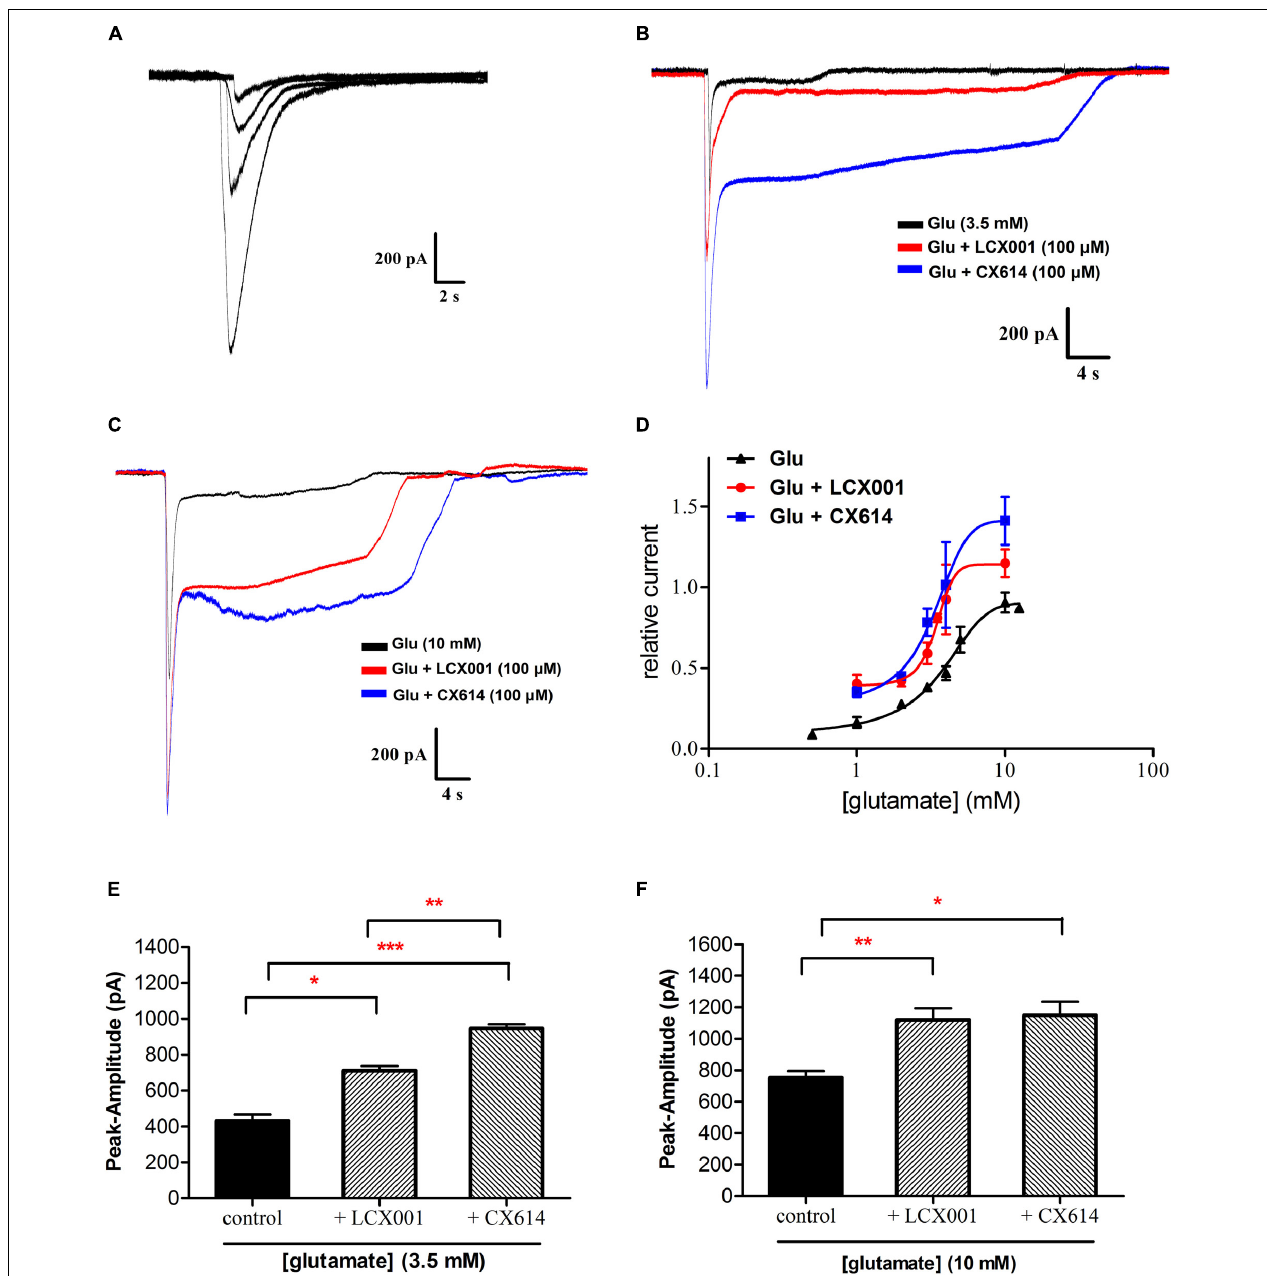
FIGURE 4 | LCX001 facilitated apparent affinity of glutamate and increased glutamate-induced amplitudes. Representative traces were obtained from HEK293 cells expressing recombinant homomeric GluA2(R) flop receptor. (A) Typical response to application of glutamate at increasing doses (1–5 mM) in a whole-cell clamp-patch recording. (B) 3.5 mM glutamate evoked currents in the absence and presence of 100 µ M LCX001 or CX614. (C) 10 mM glutamate evoked currents in the absence and presence of 100 µ M LCX001 or CX614. (D) Concentration-response profile of glutamate-mediated currents alone and in the presence of 100 µ M LCX001 or CX614. Values of amplitudes were normalized to the current from 10 mM glutamate in the same patch. The data were fitted by a Hill-type equation, and the EC 50 obtained from the fits was given in the text. The n H values of glutamate alone and in the presence of LCX001 or CX614 were 0.3, 0.84, and 0.43 respectively. (E,F) 100 µ M LCX001 and CX614 were efficacious at enhancing glutamate (3.5 and 10 mM) evoked peak amplitudes. ∗ Significant difference by one-way ANOVA, Dunnett’s test (LCX001 or CX614 treatment group vs. control group; ∗ P < 0.05, ∗∗ P < 0.01 and ∗∗∗ P < 0.001); mean ± SEM, n = 6.